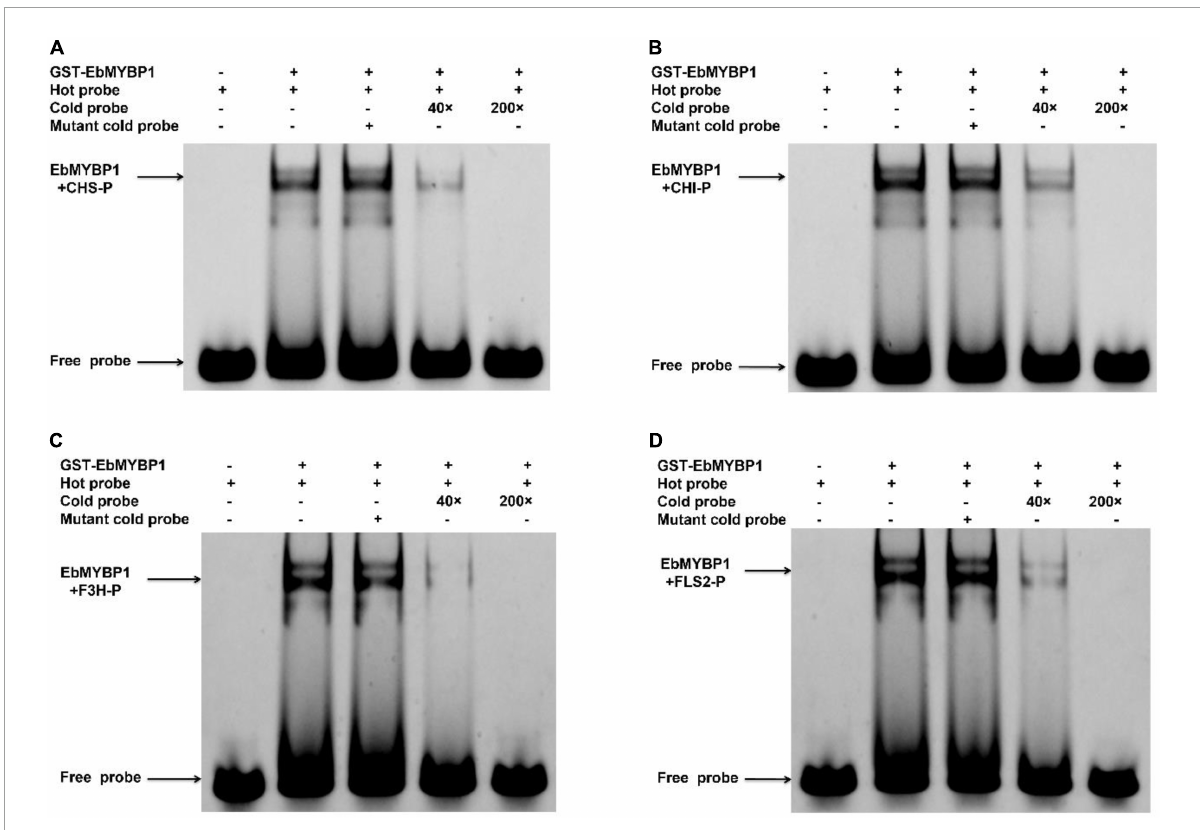
FIGURE6 Electrophoretic mobility shift assay (EMSA) of EbMYBP1 binding to the CHS (A) , CHI (B) , F3H (C), and FLS2 (D) promoter region harboring EbMYBP1-binding sites in vitro